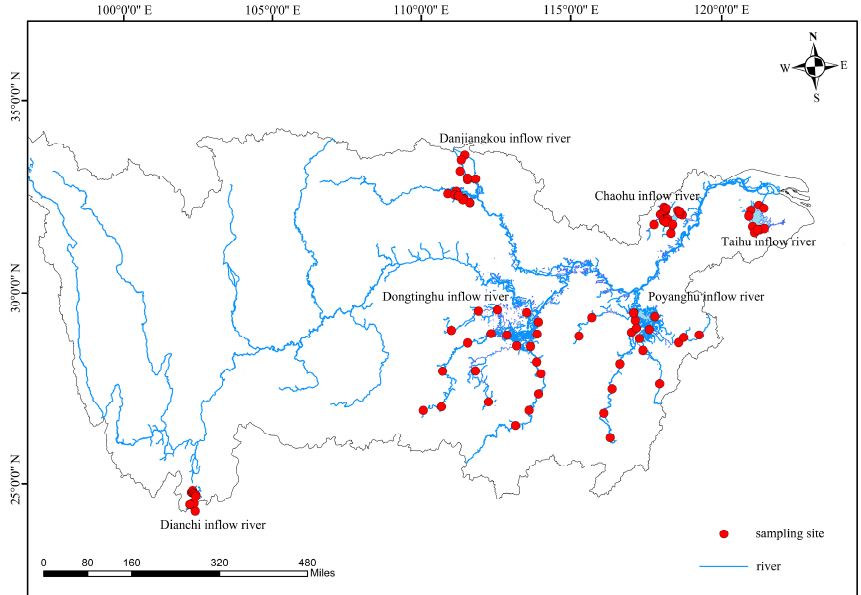
Figure 1. The location of the sampling sites in inflow rivers of six